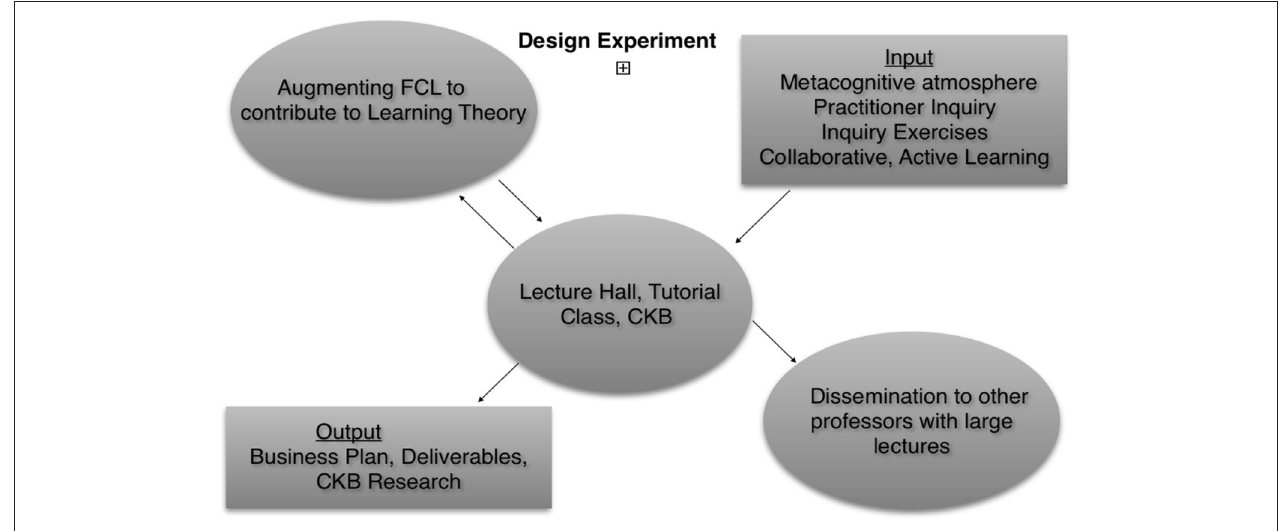
FIGURE 2 | Modified Brown (1992) graphic showing features of design experiments supplemented with particulars from this